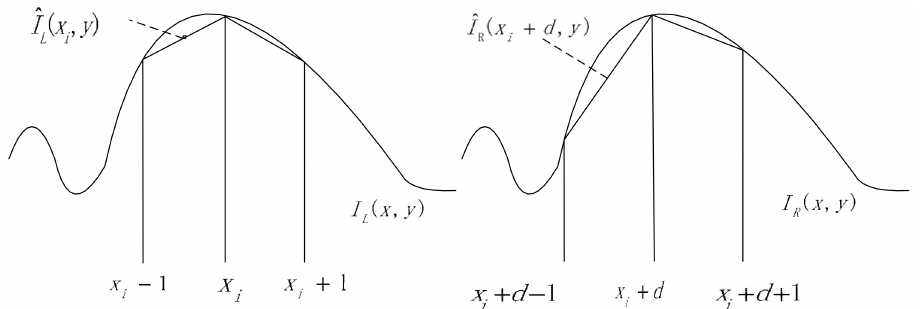
Figure 5. BT cost interpolation principal